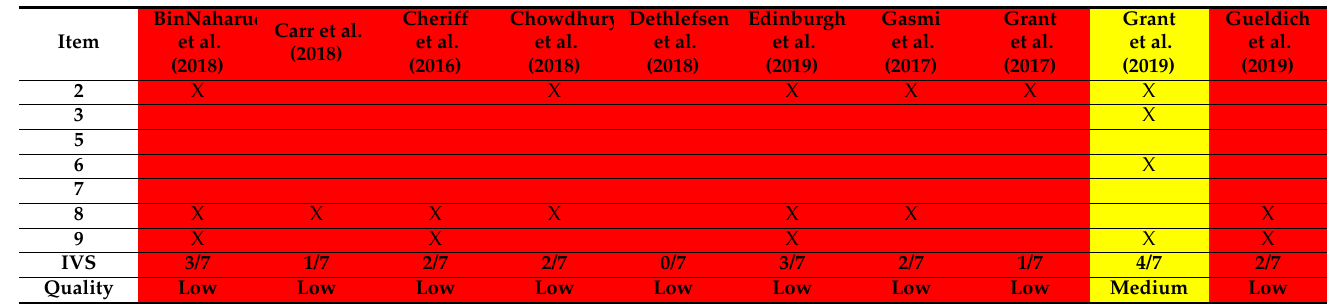
Table 3. Assessment of internal quality using IVS scale. Articles 1 to 10.